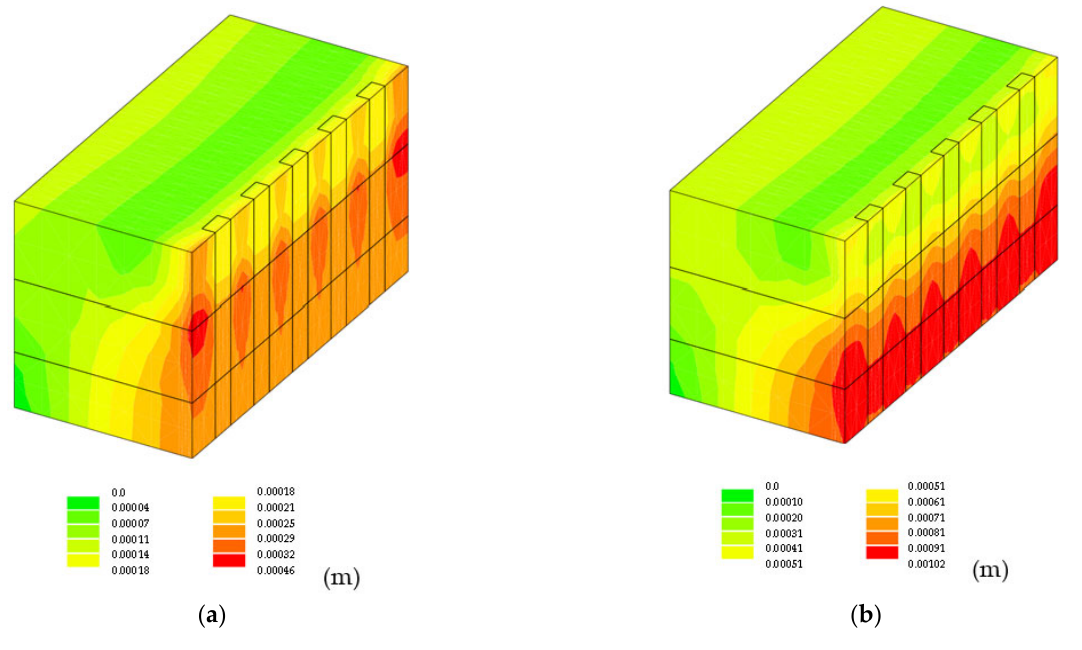
Figure 12. Iso-value of the total displacement of the retaining piles obtained with the 3D FEM analysis for ( a ) the first-stage stratum excavation and ( b ) the second-stage stratum excavation.